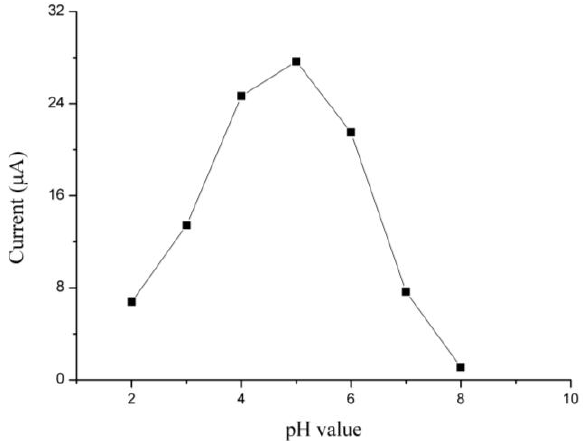
Figure 9. Effects of pH value on the stripping peaks current of 35 µg/L Cd(II).